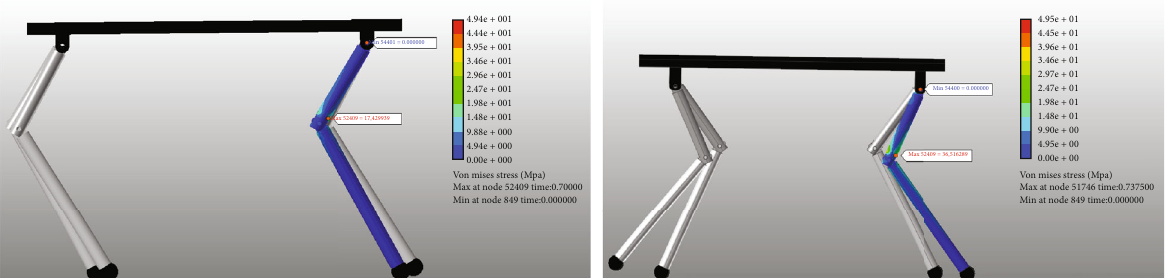
Figure 15: Rigid- fl exible coupling dynamic simulation